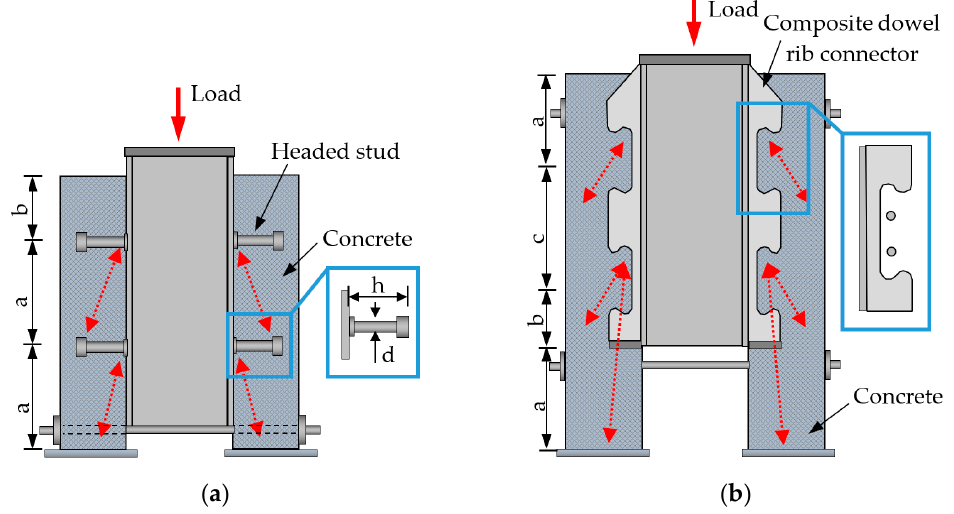
Figure 3. Push-out tests examples: ( a ) headed studs; ( b ) composite dowel rib